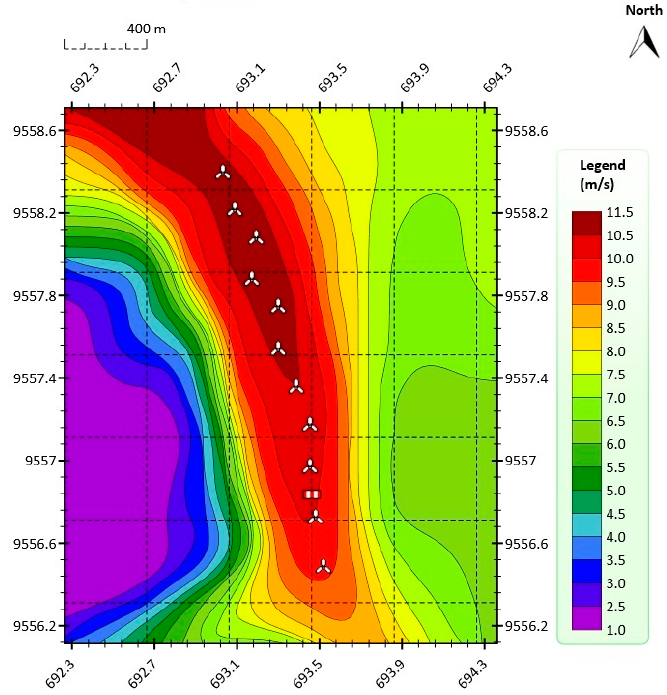
Figure 2. Annual average wind speed at 100 m AGL at the VWF in 2014.